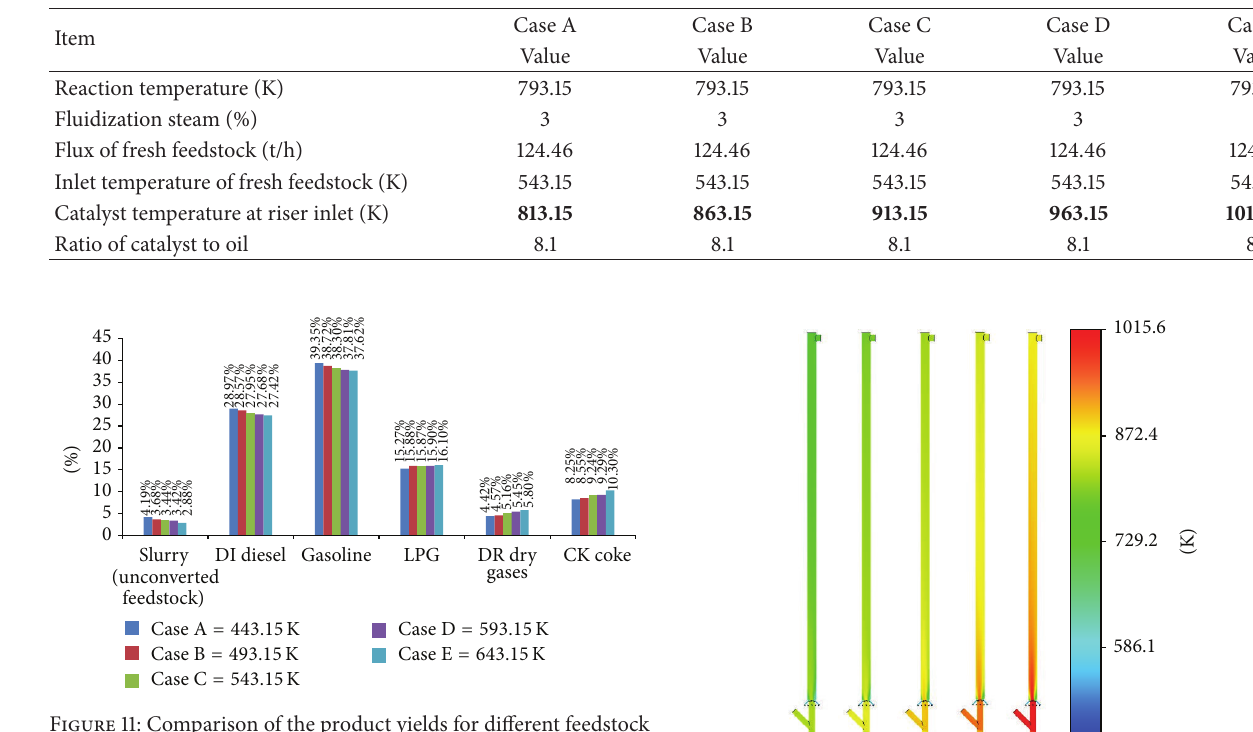
Figure 11: Comparison of the product yields for different feedstock temperatures.